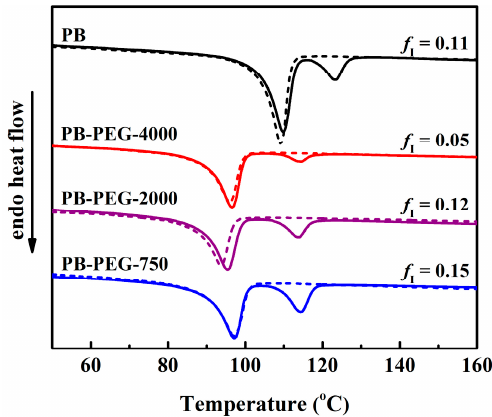
Figure 7. DSC melting curves of the PB and grafted PB-PEG copolymers after annealing at 25 °C for 50 h (solid line), where initial form II was crystallized isothermally at 60 °C. The dashed line indicates the melting curves of form II without annealing.